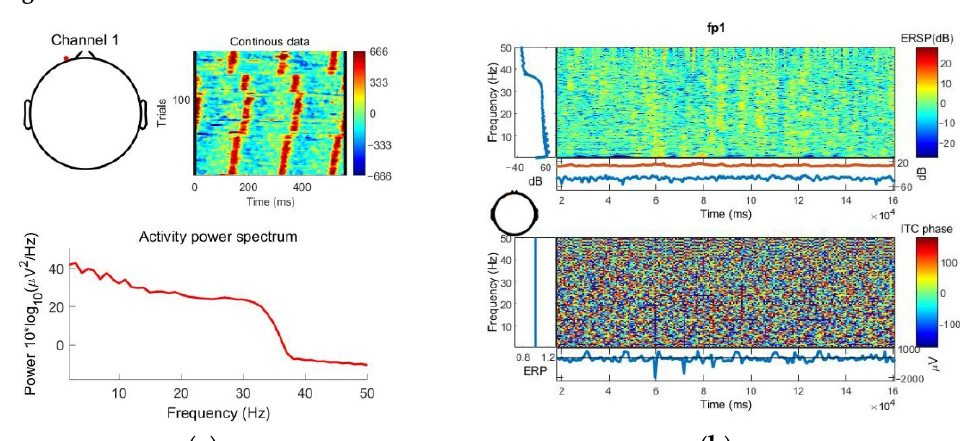
Figure 7. Related EEG feature information ( a ) channel and related power spectrum ( b ) event-related spectral perturbation and inter trial coherence with frequency.